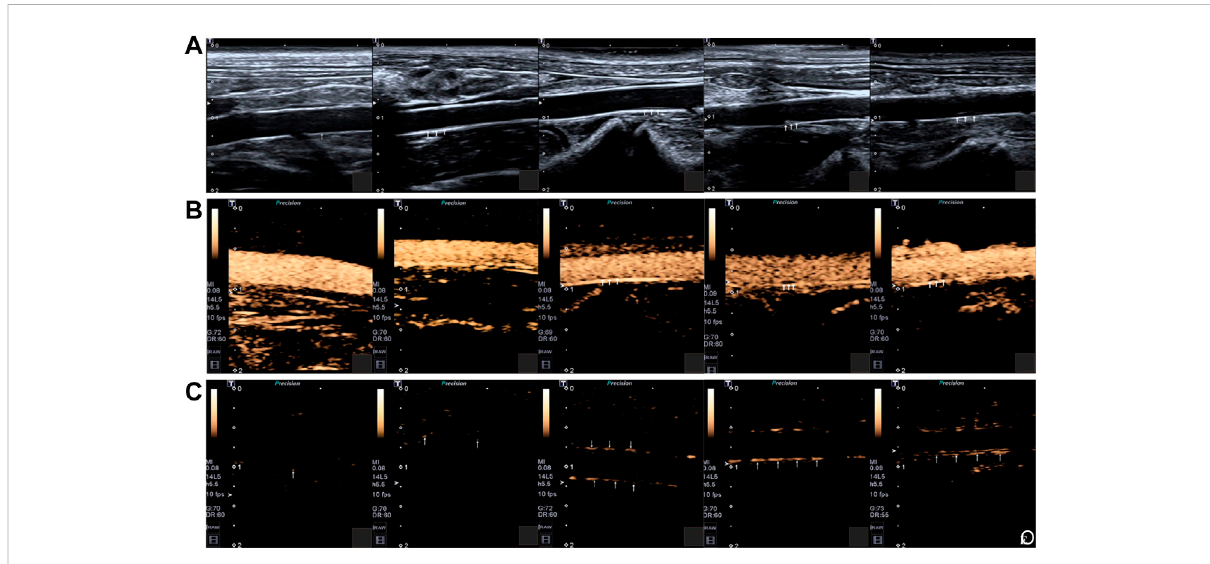
FIGURE 7 (A) Two-dimensional ultrasonography images of the abdominal aorta of rabbits in different groups. (B) SonoVue ultrasonic contrast images of theabdominalaortaofrabbitsindifferentgroups. (C) ICAM-1-targetednanoultrasoniccontrastimagesoftheabdominalaortaofexperimentrabbits in different groups. Five rabbits in each group: control group; week-4 group; week-8 group; week-12 group; week-16 group. The intima-media membrane and the plaque on the wall were indicated by the arrows (Copyright permission from Springer Nature) (Li et al.,